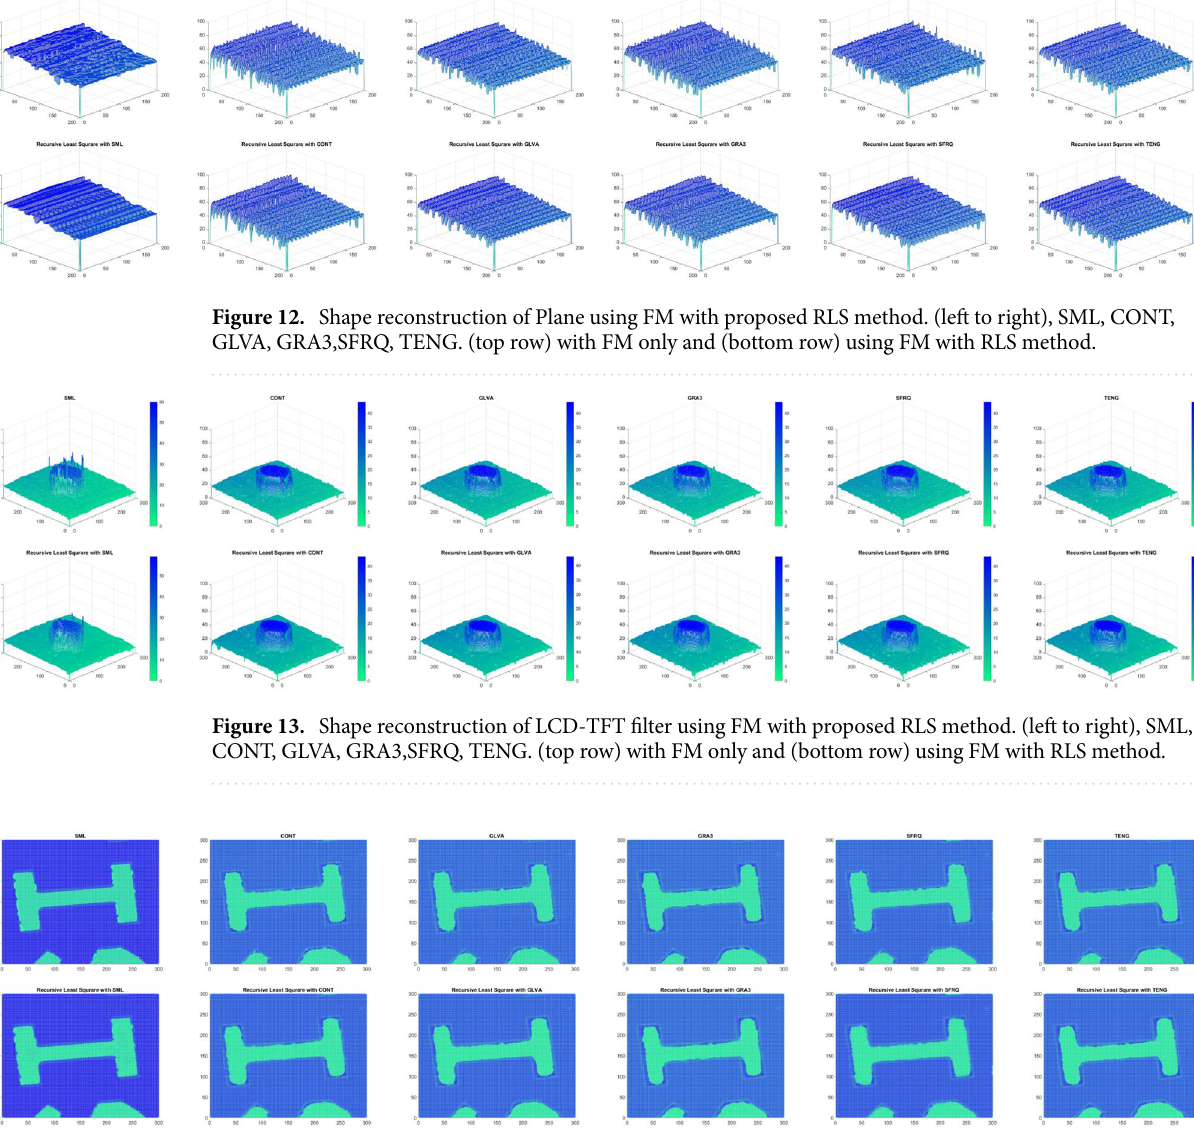
Figure 14. Shape reconstruction of Image-I using FM with proposed RLS method. (left to right), SML, CONT, GLVA, GRA3,SFRQ, TENG. (top row) with FM only and (bottom row) using FM with RLS method.